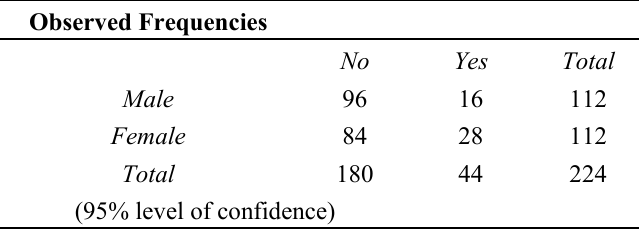
Table 2. Cross tabulation analysis between gender and depression.